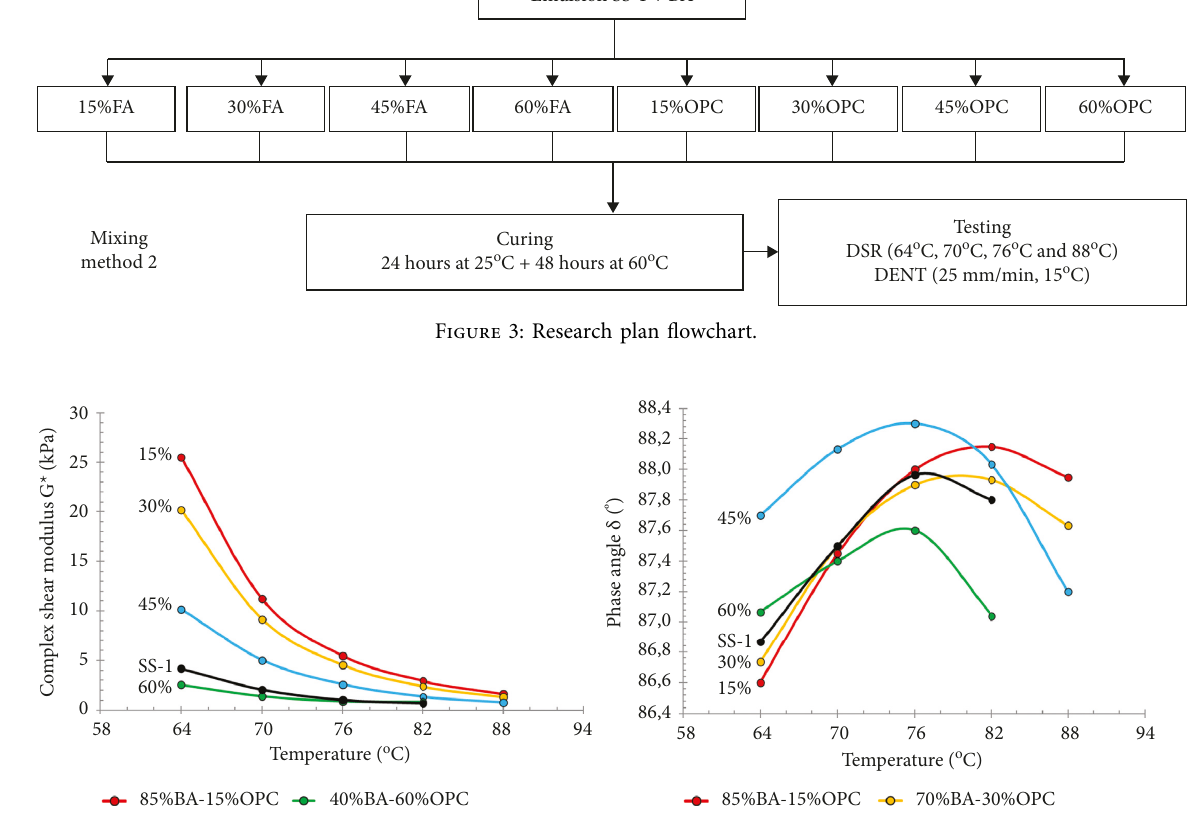
Figure 4: DSR results, shear modulus, and phase angle @ 1.59Hz, of the residual bitumen from the emulsion (SS-1) and Portland cement mixes with mixing method